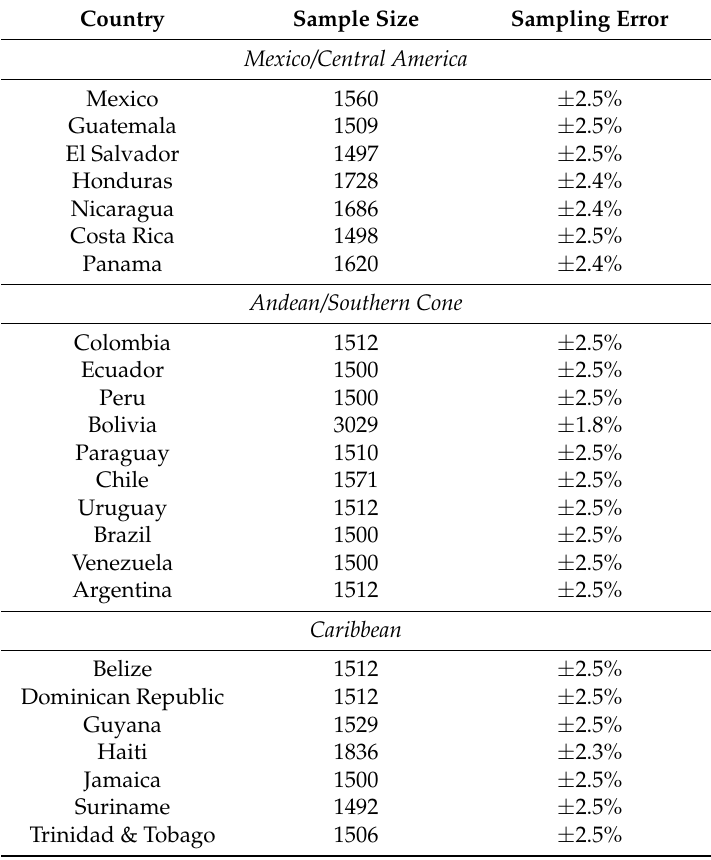
Table A1. Sample sizes and sampling errors in the 2012 Americas Barometer.